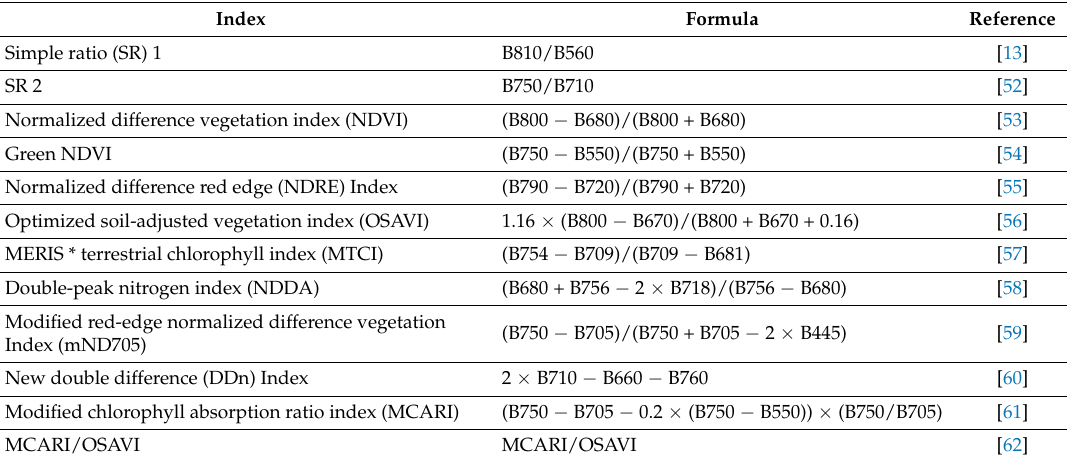
Table 1. Published vegetation indices used in this